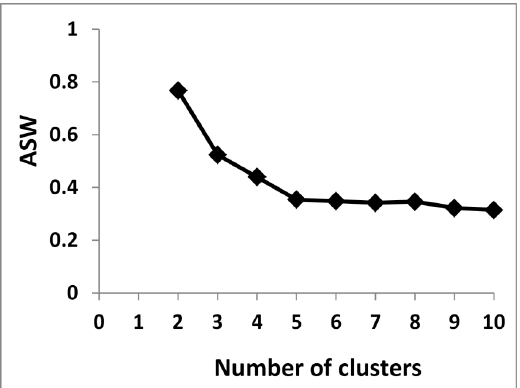
Figure 1. Average silhouette width versus number of clusters (from k -means).